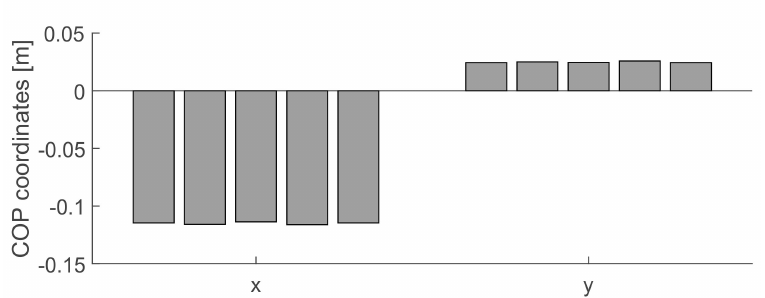
Figure 9. Stability test. Each bar is the component X and Y of the COP Calib computed at time intervals of 1